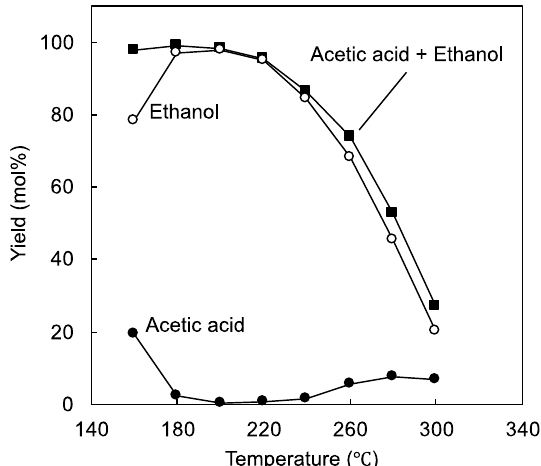
Figure 5. E ff ect of reaction temperature on hydrogenation of aqueous acetic acid (10 g / L) to ethanol (column size, 9.4-mm inner diameter, 210-mm length; pump flow rate, 0.3 mL / min; H 2 flow rate, Figure 5. Effect of reaction temperature on hydrogenation of aqueous acetic acid (10 g/L) to ethanol 60 mL / min; pressure, 10 (column size, 9.4-mm inner diameter, 210-mm length; pump flow rate, 0.3 mL/min; H 2 flow rate, 60 mL/min; pressure, 10 MPa).